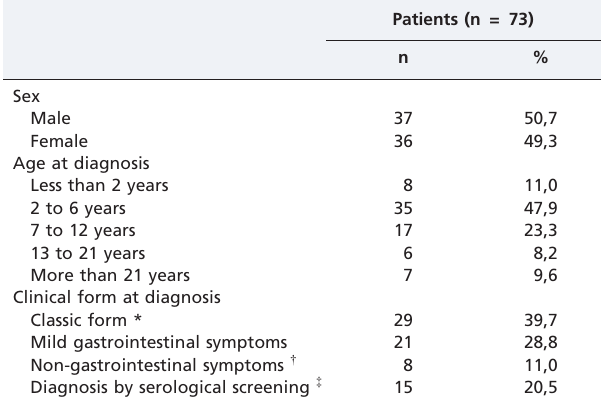
Table 1 - Sex, age and clinical characteristics of the cases at the time of diagnosis.